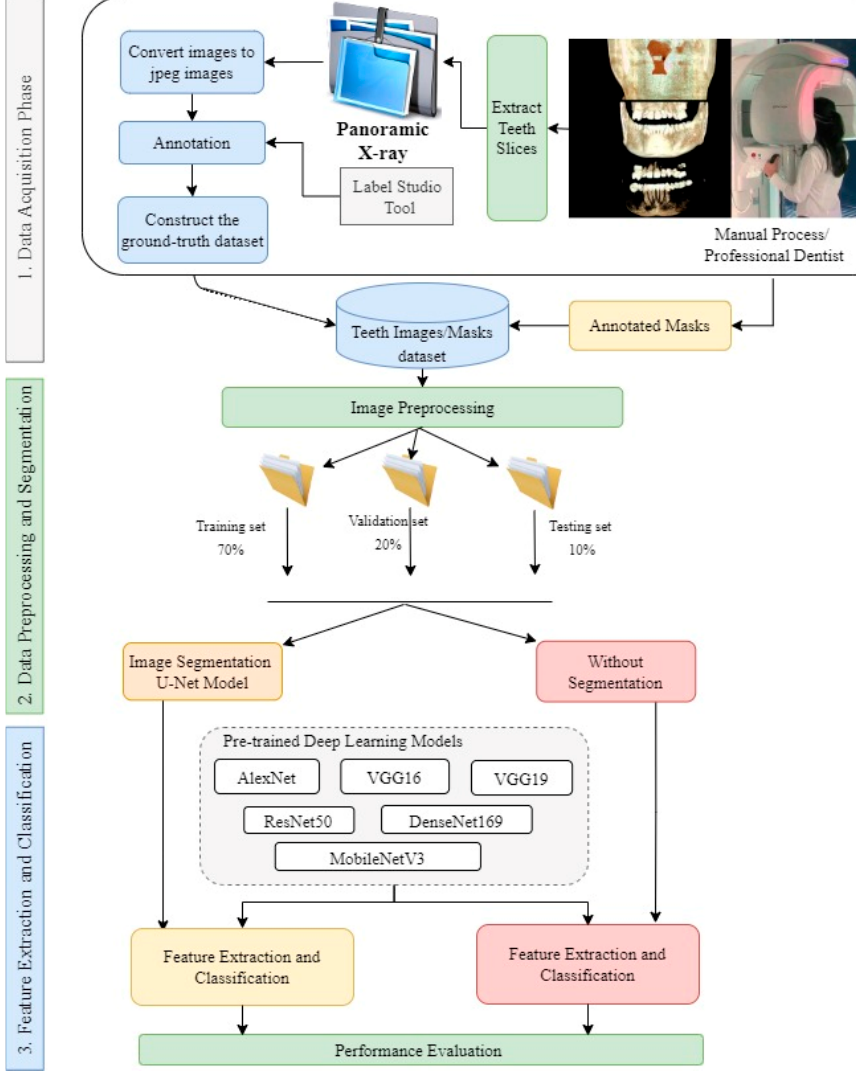
Figure 1. The study design methodology.